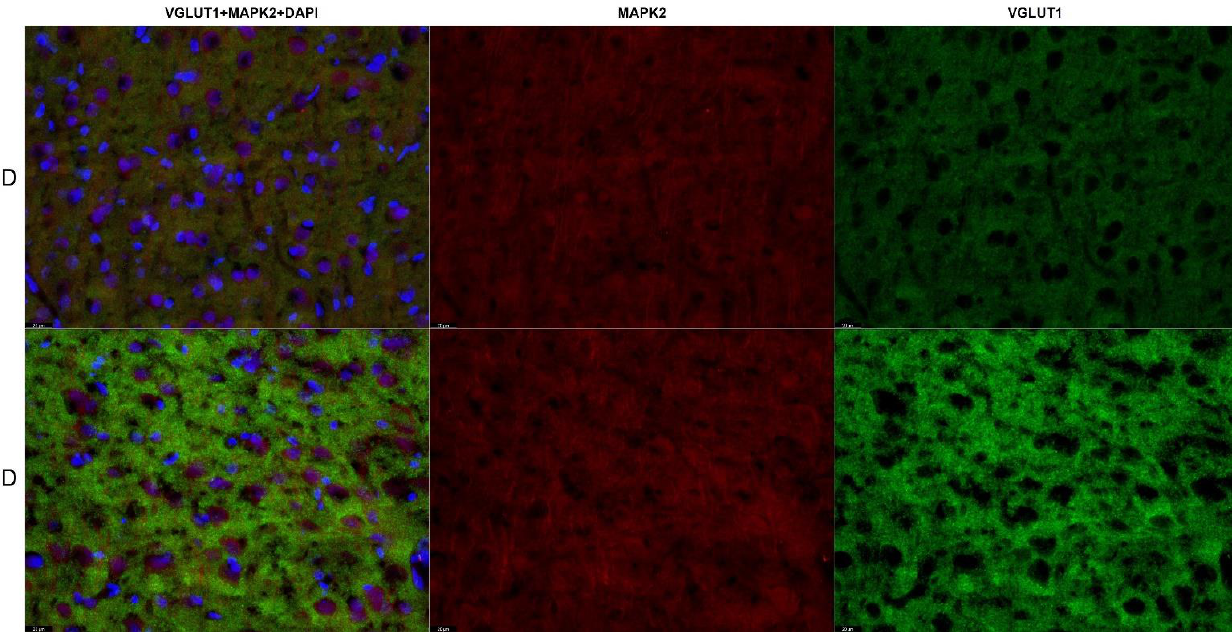
Figure 10. Immunohistofluorescence staining of the location of VGLUT1 in neurons in the mPFC of female offspring. Representative images showing VGLUT1 immunoreactivity (green) in MAP2 positive neurons (red) with DAPI-stained nuclei (blue). n = 6 in each group. Magnification × 40, scale bar 20 μm.